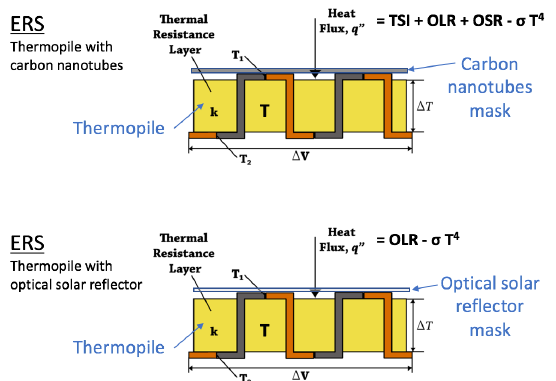
Figure 3. Earth Radiative Sensors (ERS) measurement principle. On each side of UVSQ-SAT, there are these two sensors. TSI, Total Solar Irradiance; OLR, Outgoing Longwave Radiation; OSR, Outgoing Shortwave